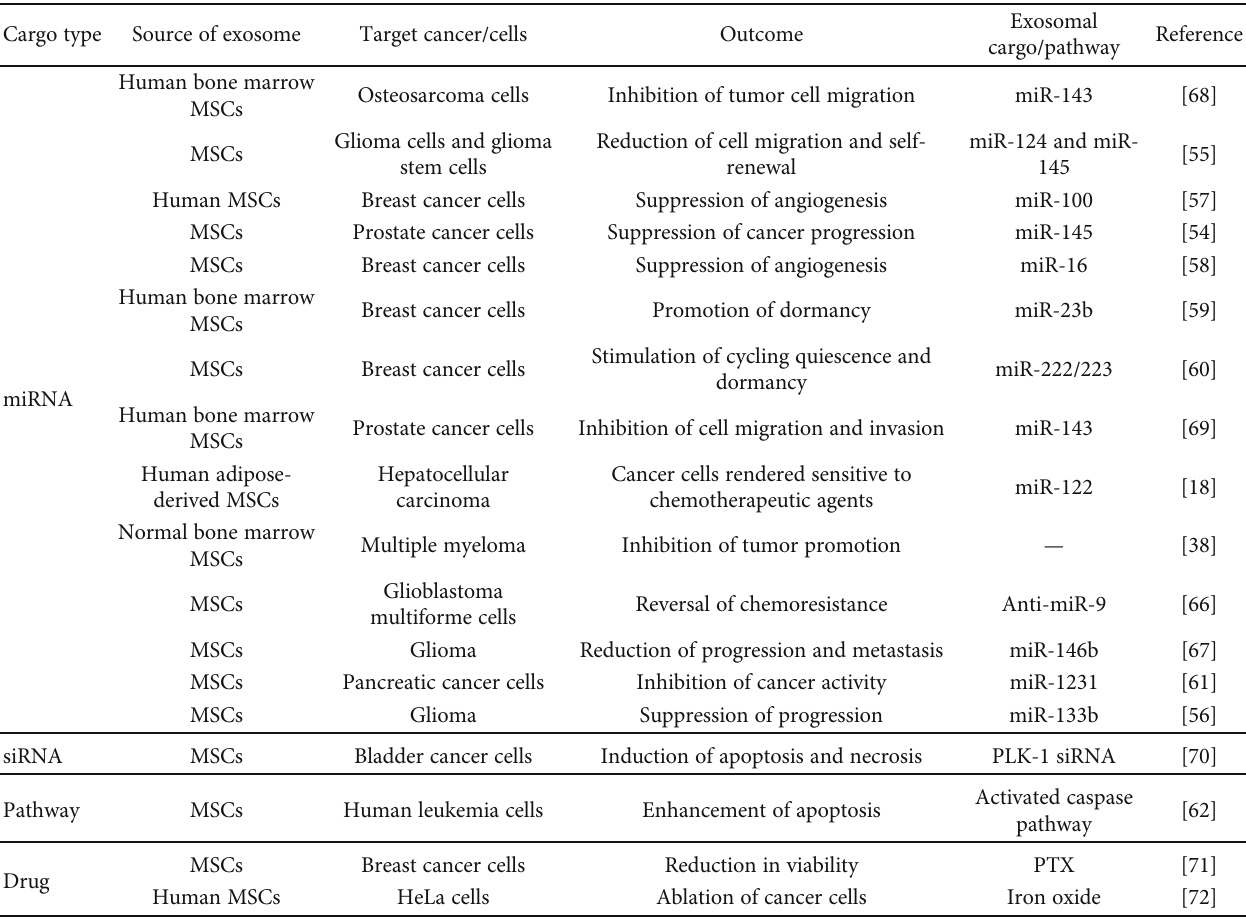
Table 2: Tumor/cancer-inhibiting cargoes transported by MSC-derived